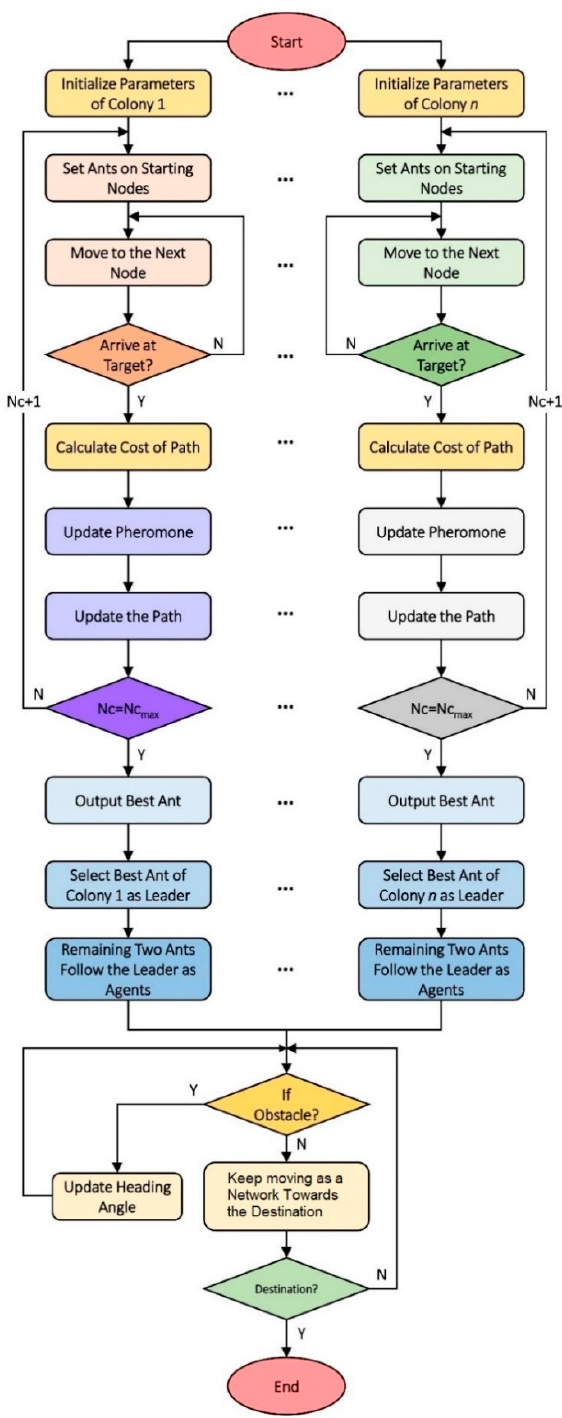
Figure 4. Flowchart of the Proposed Model.